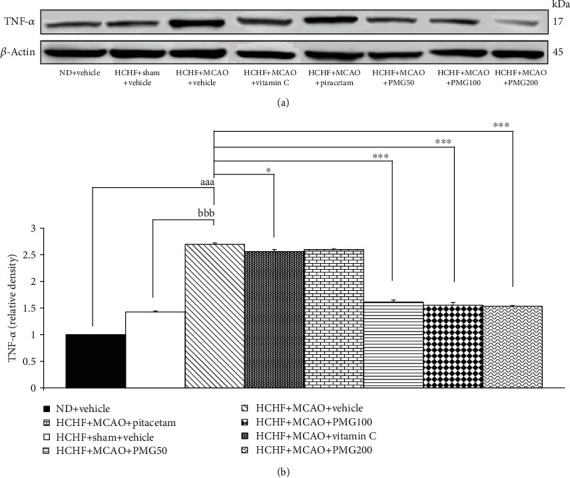
Effect of various doses of PMG on the expression of TNF-α in the cerebral cortex was detected by Western blotting. (a) Representative western blot showing the levels of TNFα. (b) Relative density of TNFα. Data are presented as mean ± SEM (n = 6/group). aaap values < 0.001; compared between naïve control rats which received normal diet and vehicle, and metabolic syndrome+MCAO rats which received HCHF, MCAO, and vehicle, bbbp values < 0.001; compared between sham rats which received HCHF, sham operation, and vehicle, and metabolic syndrome+MCAO rats which received HCHF, MCAO, and vehicle and ∗, ∗∗∗p values < 0.05 and 0.001, respectively; compared to metabolic syndrome+MCAO rats which received HCHF, MCAO, and vehicle. ND: normal diet; HCHF: high-carbohydrate high-fat diet; MCAO: middle cerebral artery occlusion; vitamin C: the vitamin C at a dose of 250 mg.kg−1 BW; piracetam: the piracetam at a dose of 250 mg.kg−1 BW; PMG 50, PMG 100, and PMG 200: the phytosome containing the combined extract of mulberry fruit and ginger at doses of 50, 100, and 200 mg.kg−1 BW, respectively.